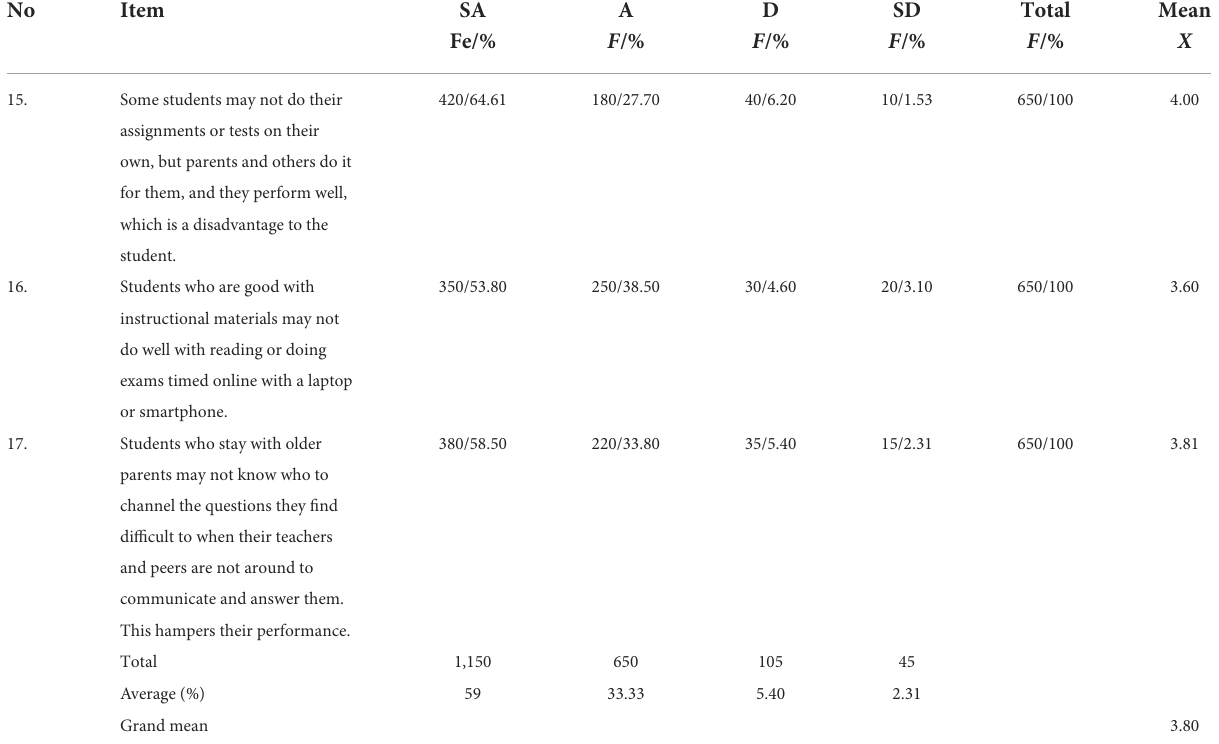
TABLE 4 Responses to the exogenous influences on the AP of the students, which are not only a result of a non-regulated